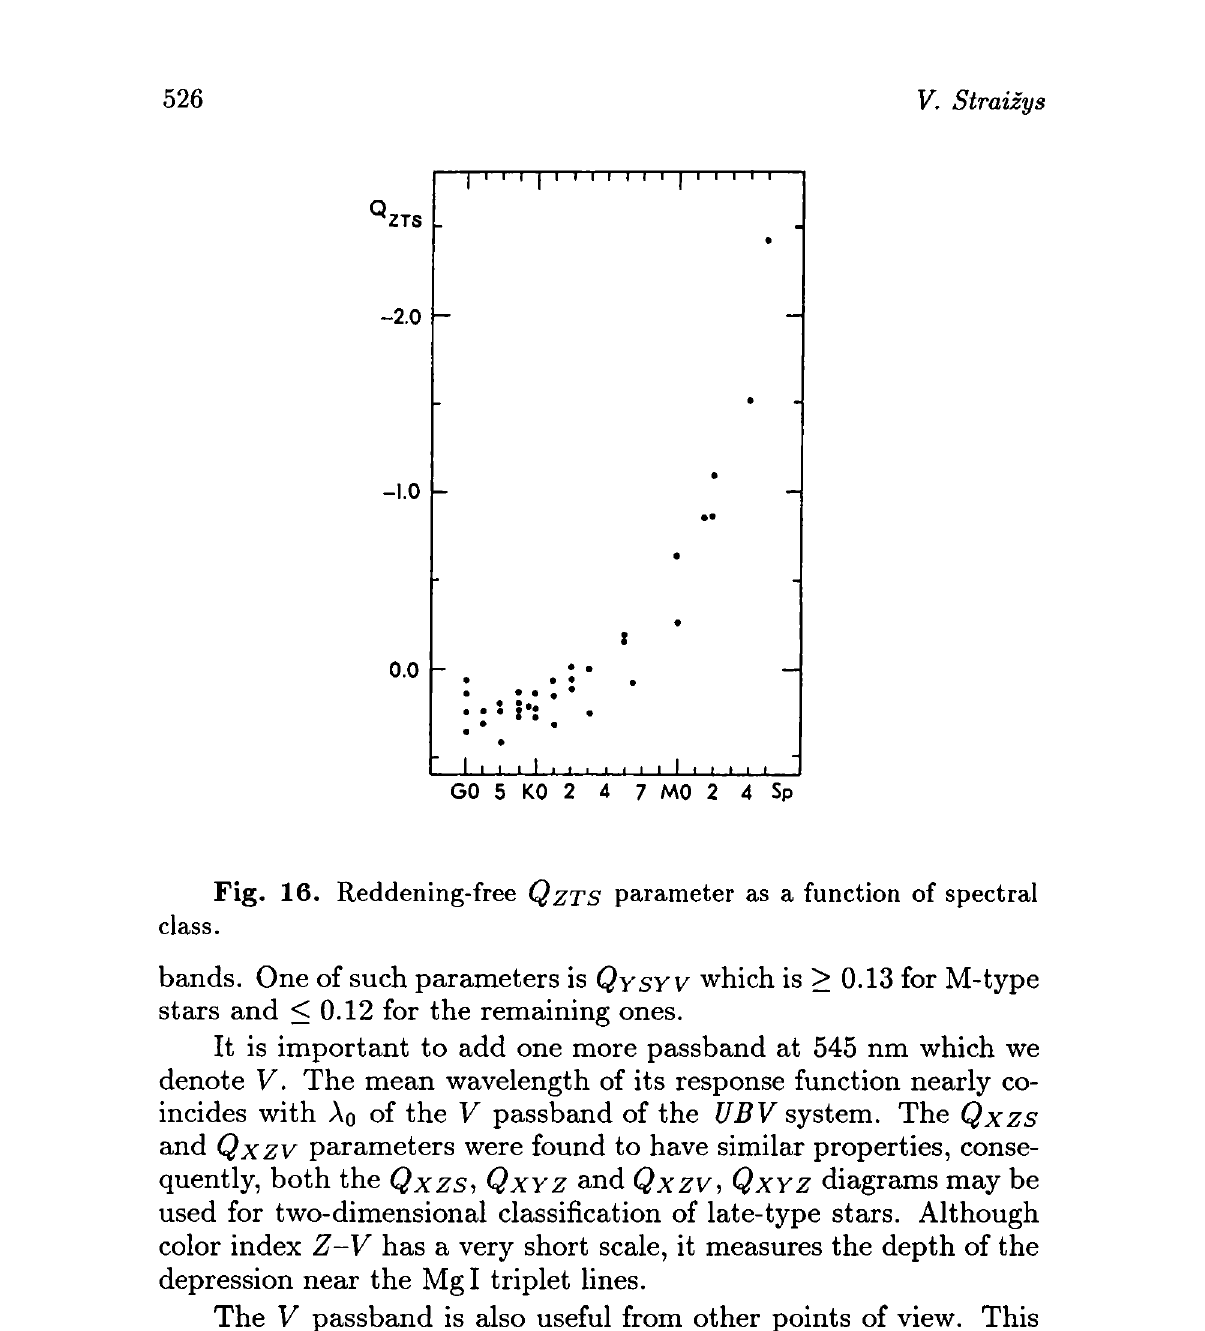
Fig. 16. Reddening-free QZTS parameter as a function of spectral